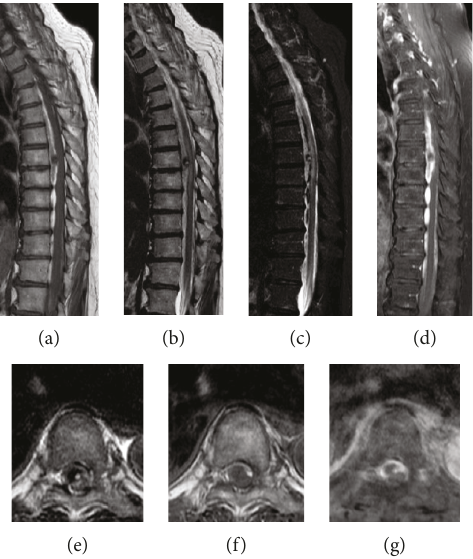
Figure 1: Sagittal (T1-weighted (a), T2-weighted (b), STIR (c), and contrast-enhanced (d)) and axial (T1-weighted (e), T2-weighted (f), and contrast-enhanced (g)) magnetic resonance imaging revealed a large subdural hematoma extending from T2 to L3 and compressing the spinal cord from the ventral side at 7 days after onset.